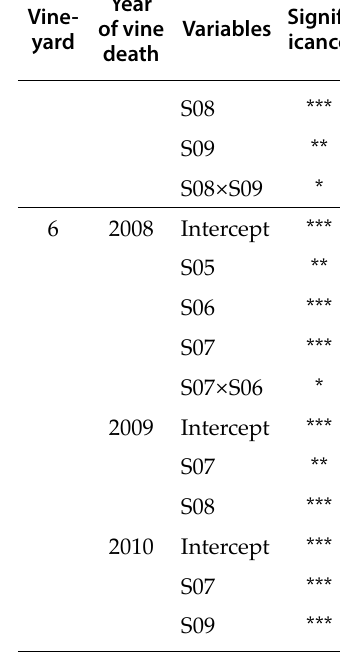
Table 3. Odds ratio (Estimate and 95% Confidence Intervals) for the best-fit binary regression logistic model that predicted the risk of vine death in 2008, 2009 or 2010 based on Eutypa dieback symptoms in the previous four years (i.e. S07 = symp - toms in 2007) for the three vineyards. * P <0.01, ** P <0.001, *** P <0.0001. Vine-